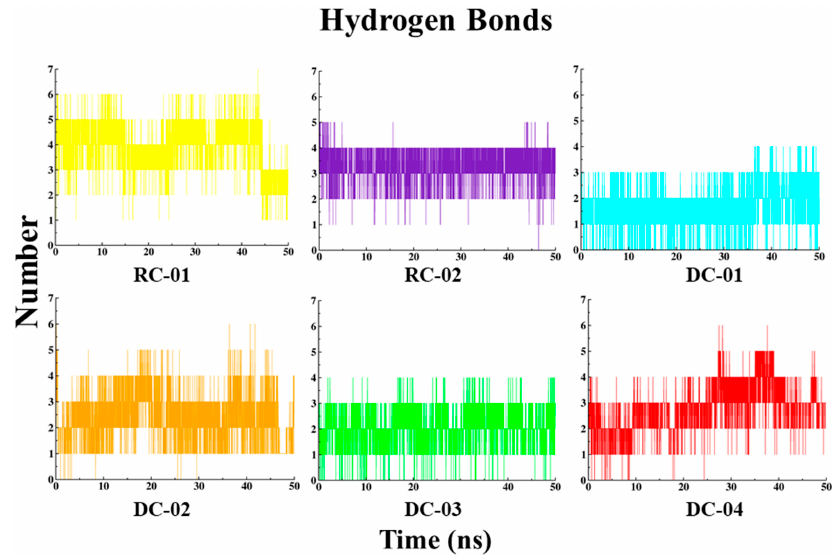
Figure 7. The HB interaction plot of the designed and reference compounds for 50 ns. Molecules 2023 , 28 , x FOR PEER REVIEW